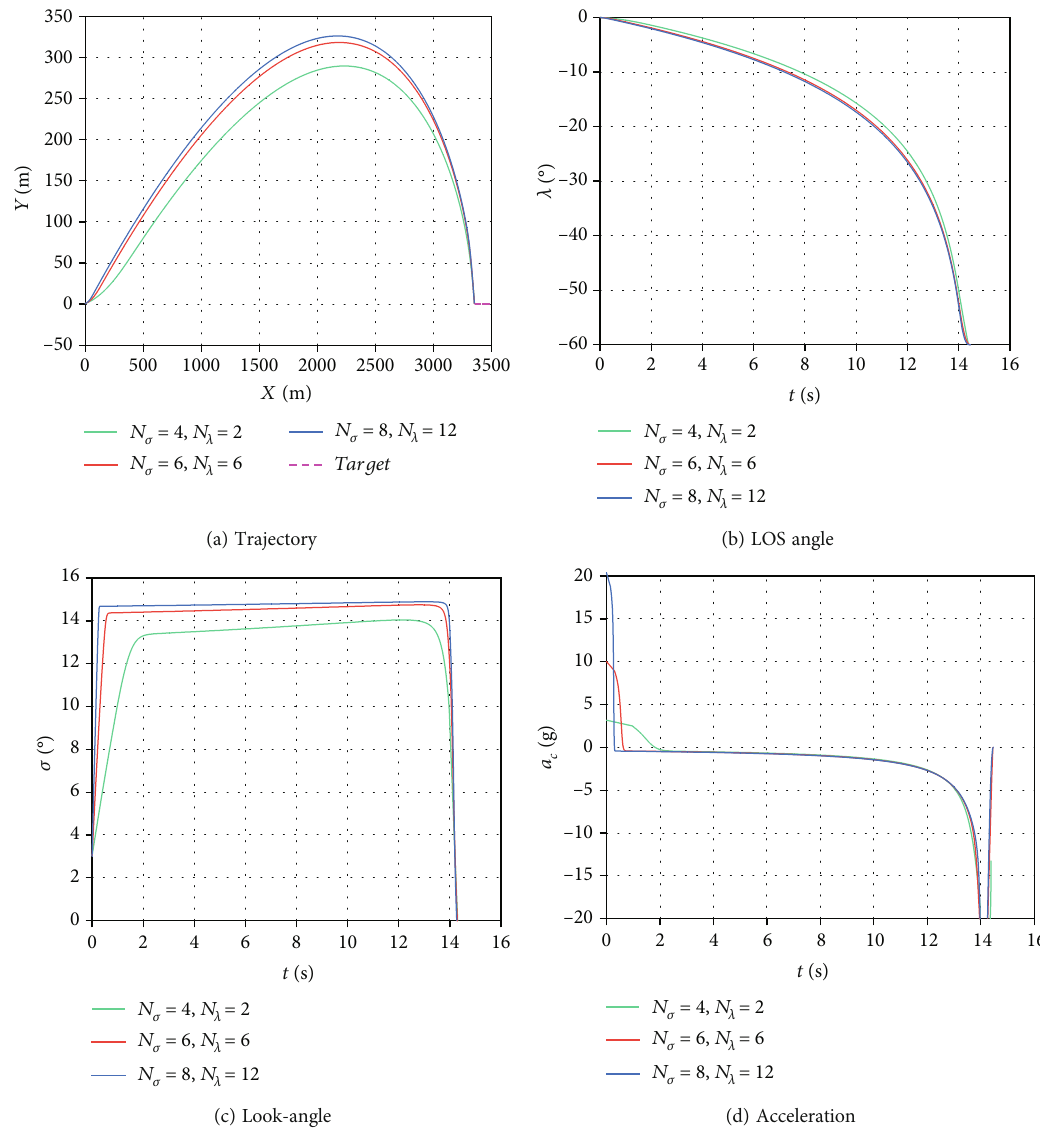
Figure 6: The results of di ff erent guidance coe ffi cients considering FOV